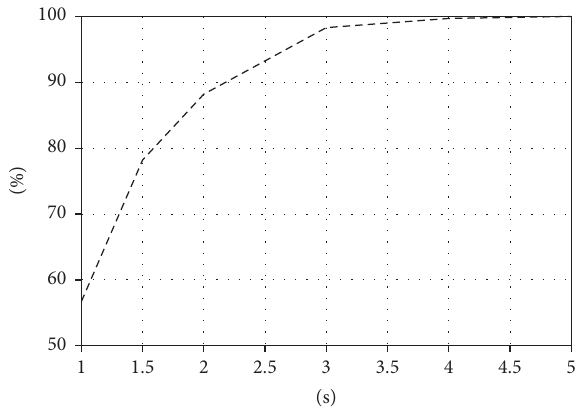
Figure 6: Proportion of “aggressive” simulations as a function of soldier reaction